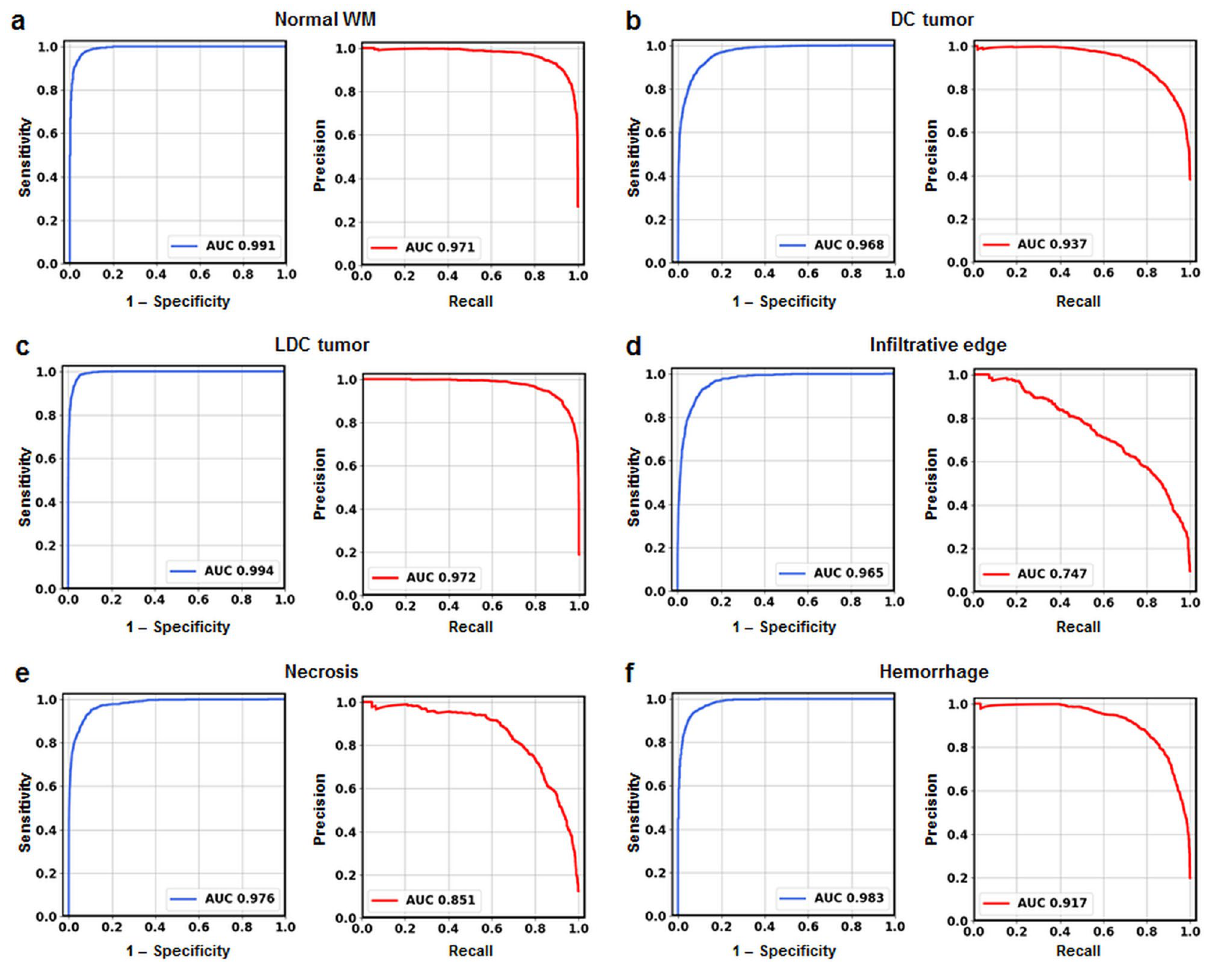
Figure 6. Receiver operating characteristics (ROC) curves and precision-recall (PR) curves calculated using one-vs-rest strategy for 6 different tumor histological components including ( a ) normal white matter, ( b ) densely cellular tumor, ( c ) less densely cellular tumor, ( d ) tumor infiltrative edge, ( e ) tumor necrosis and ( f ) hemorrhage. All 6 ROC curves showed high areas under curve (AUC), indicating strong sensitivity and specificity in detecting these tumor histologic components. Tumor infiltrative edge did not perform as well as other histologic components in precision-recall analysis, indicating that tumor infiltration could be overestimated by the model. Normal WM normal white matter, DC tumor densely cellular tumor, LDC tumor less densely cellular tumor.